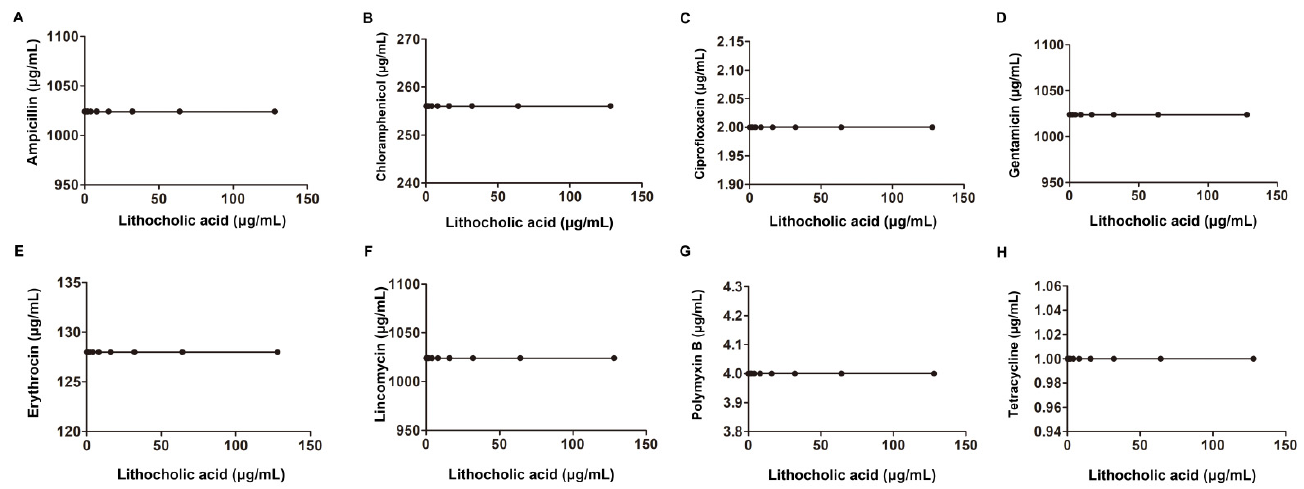
Figure 5. Interaction of LCA with Amp, Ery, Genta, Cip, Lin, Tet, Cpl and Pmb against E. coli ATCC25922 ( A – H ).